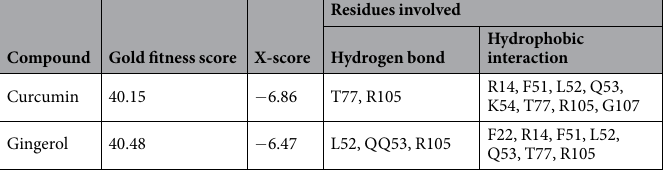
Table 1. Binding scores of selected natural compounds and the residues involved in their interaction with